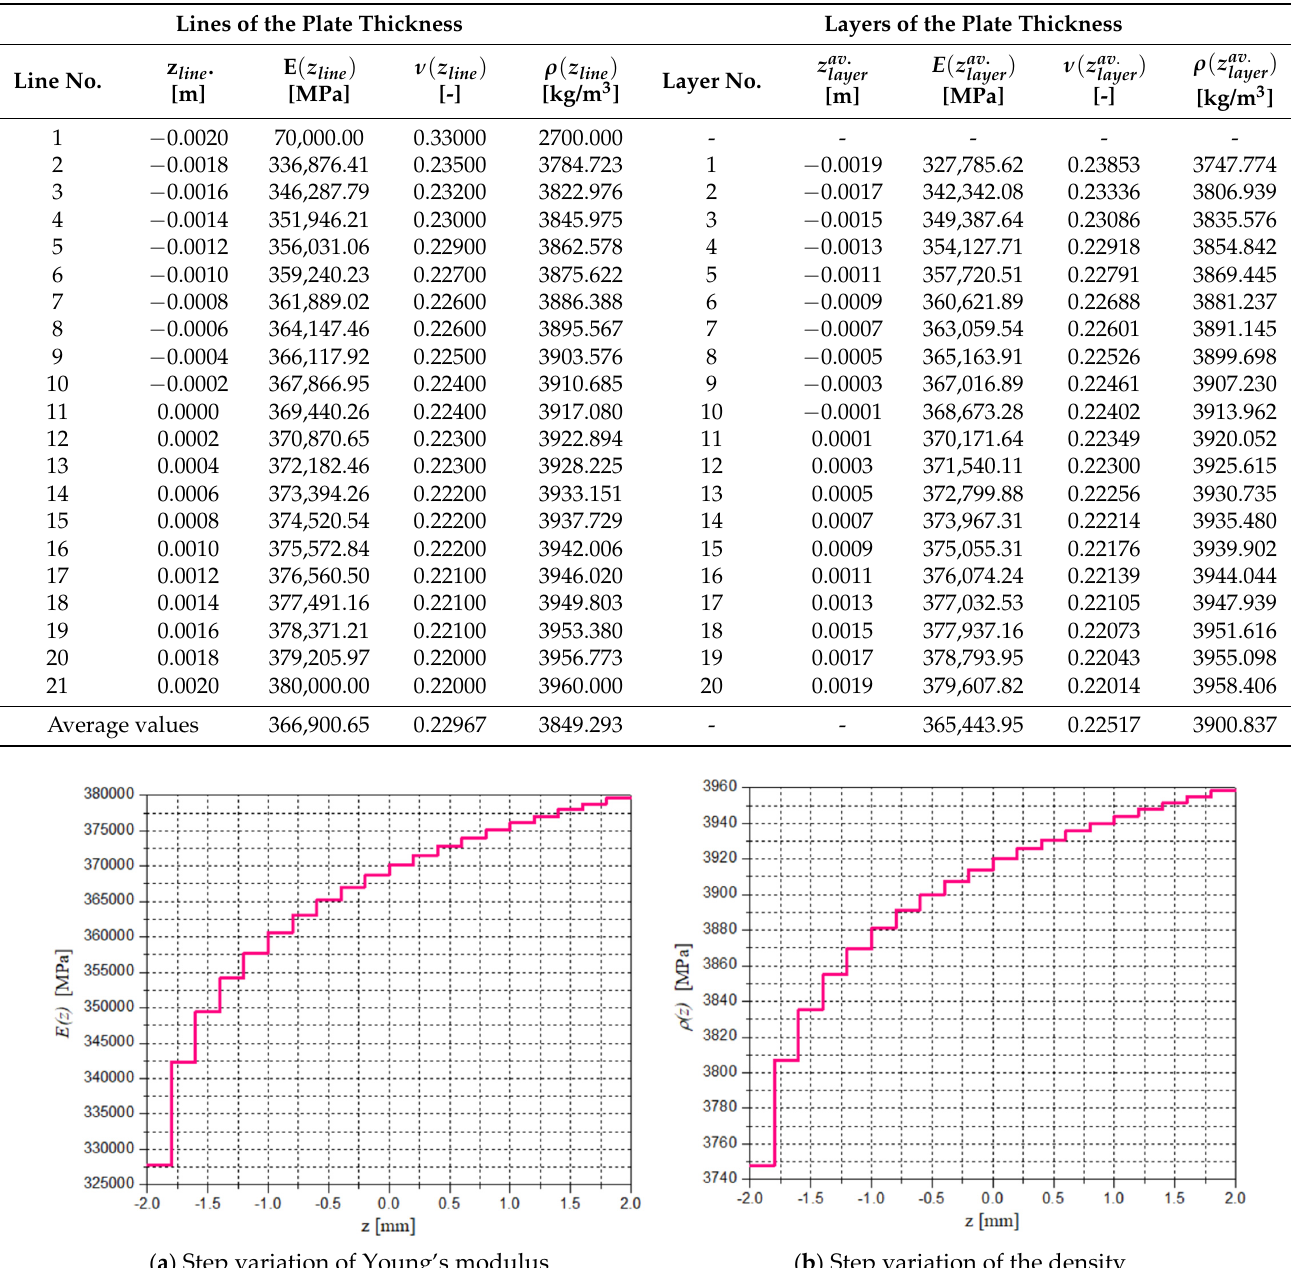
Table 2. Layer material properties for k = 0.05.